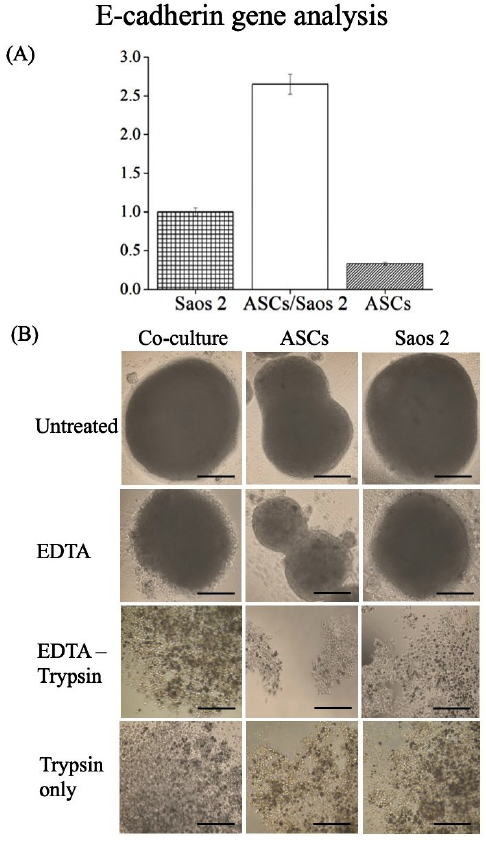
Figure 3. ( A ) Differential expression of E-cadherin by multi-cell spheres. ( B ) Multi-cell sphere separation test in homo- and heterotypic cell spheres [12]. Scale bar = 50 μ m.